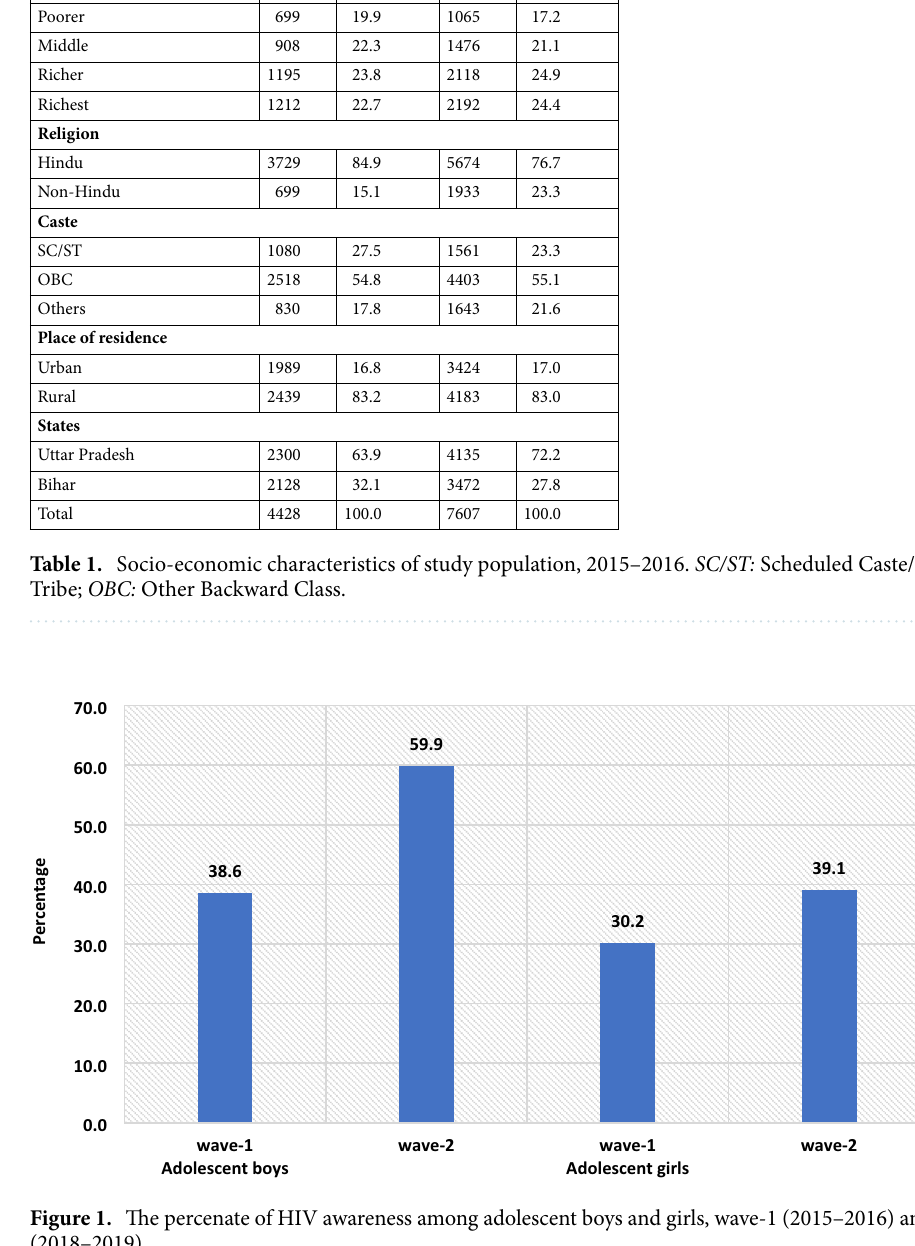
boys and girls. Figure 1 represents the change in HIV awareness among adolescent boys and girls. The percentage of ado- lescent boys who had awareness regarding HIV increased from 38.6% in wave-1 to 59.9% in wave-2. Among adolescent girls, the percentage increased from 30.2% in wave-1 to 39.1% in wave-2. Table 2 represents the summary statistics for explanatory variables used in the analysis of UDAYA wave-1 and wave-2. The exposure to mass media is almost universal for adolescent boys, while for adolescent girls, it increases to 93% in wave-2 from 89.8% in wave-1. About 35.3% of adolescent boys were engaged in paid work during wave-1, whereas in wave-II, the share dropped to 33.5%, while in the case of adolescent girls, the estimates